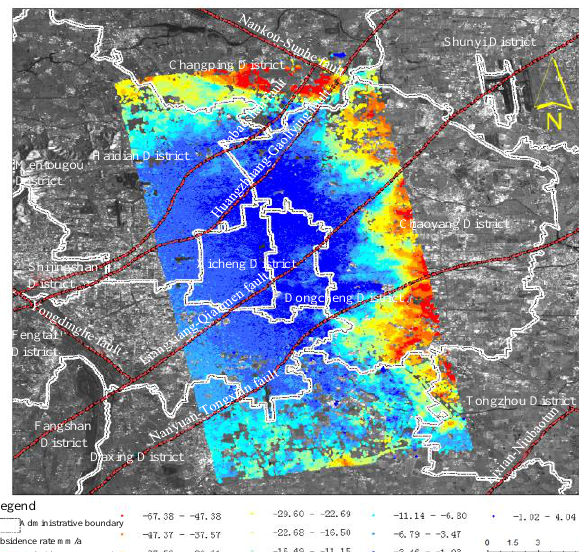
Figure 5. Overlay Chart of PS Results and Fault Zones At the quaternary depression in Shahe Town of Changping District, the spatial distribution pattern of subsidence funnel depends on Nankou-Sunhe fault zone. The main cause of land